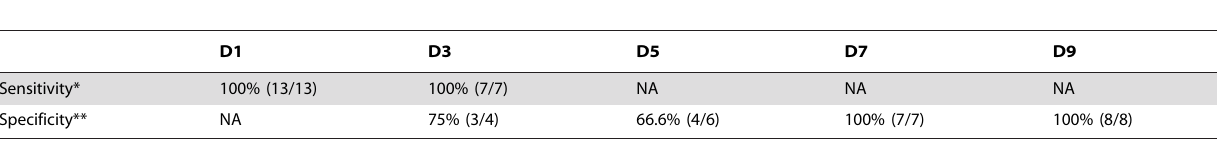
Table 4. Sensitivity and specificity of pap31 LAMP assay in detecting B. bacilliformis from experimentally infected sand flies compared to